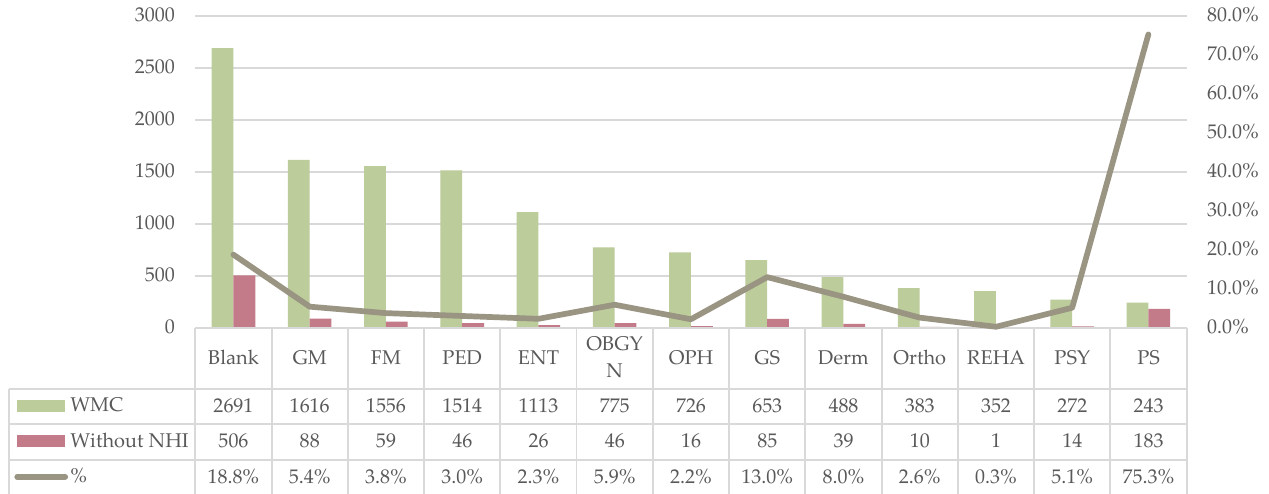
Figure 2. Urbanization level of the location of clinics without health insurance. WMC: Western Medical Clinic.